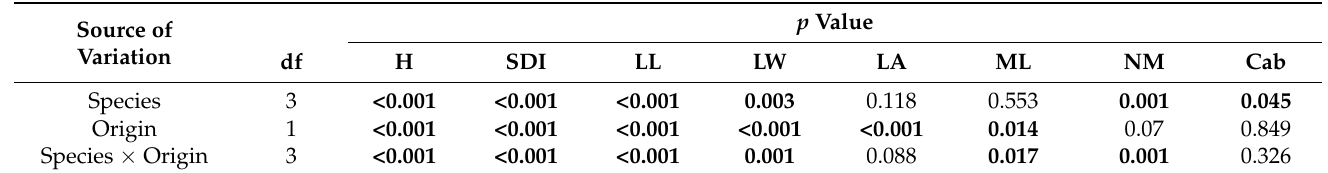
Table 3. ANOVA of the effects of species, origin, and their interaction on plant growth and morphol- ogy